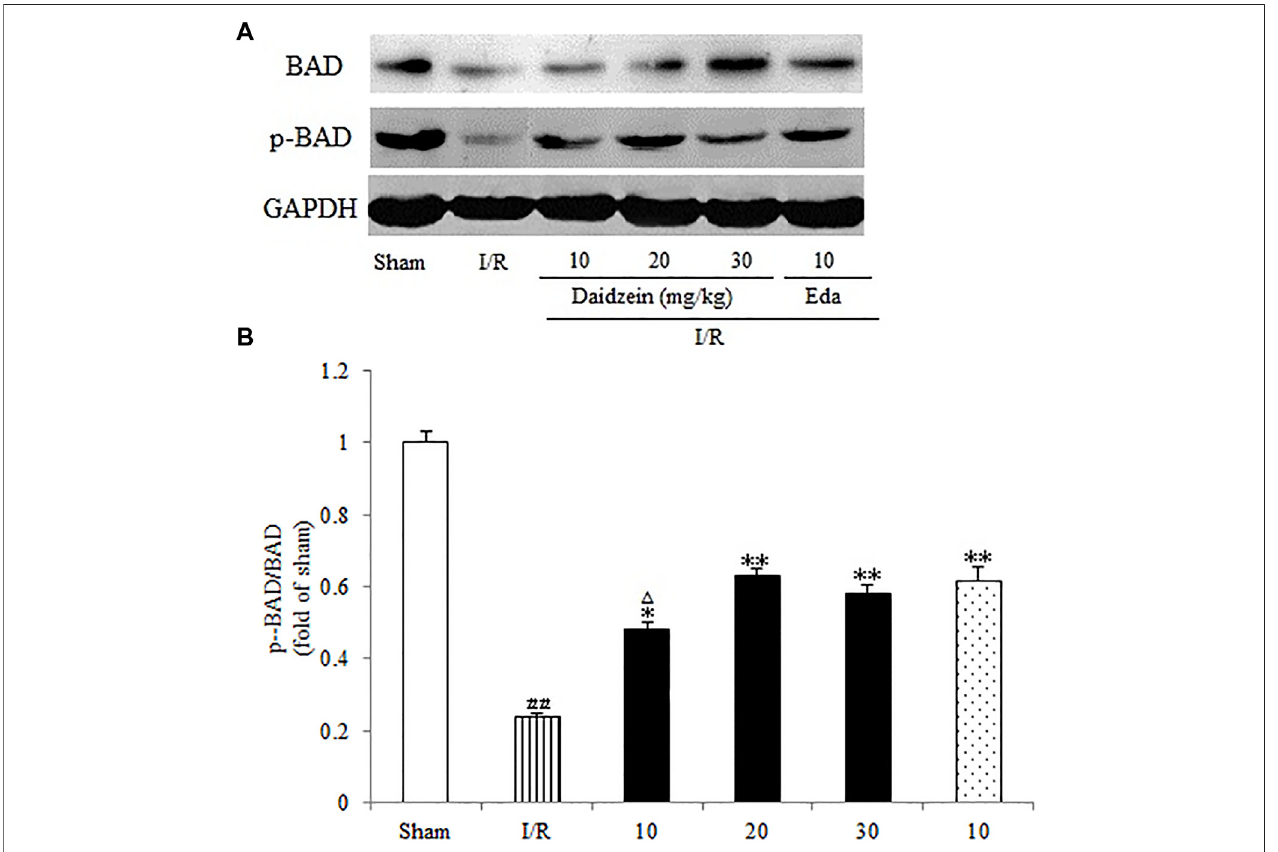
FIGURE7| Immunoblottinganalysisofproteinlevelsofp-mTOR/mTOR inrats ’ braininfarctregion. (A) Representativewesternblots. (B) Ratioofp-mTOR/mTOR. Valuesareindicatedasmeans ± standarderrorsofthemeans(SEMs; n (cid:2) 3). ## p < 0.01noticeablydistinctfromSham;** p < 0.05,noticeablydistinctfromI/R; △ p < 0.05, △△ p < 0.01, compared with the Eda